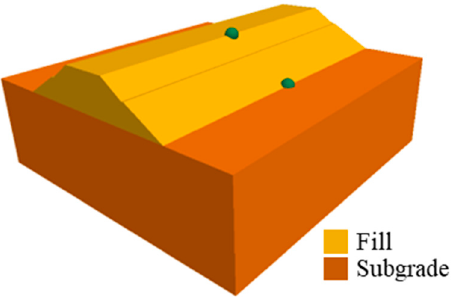
Figure 8. Numerical model and numerical monitoring points of the fill subgrade.